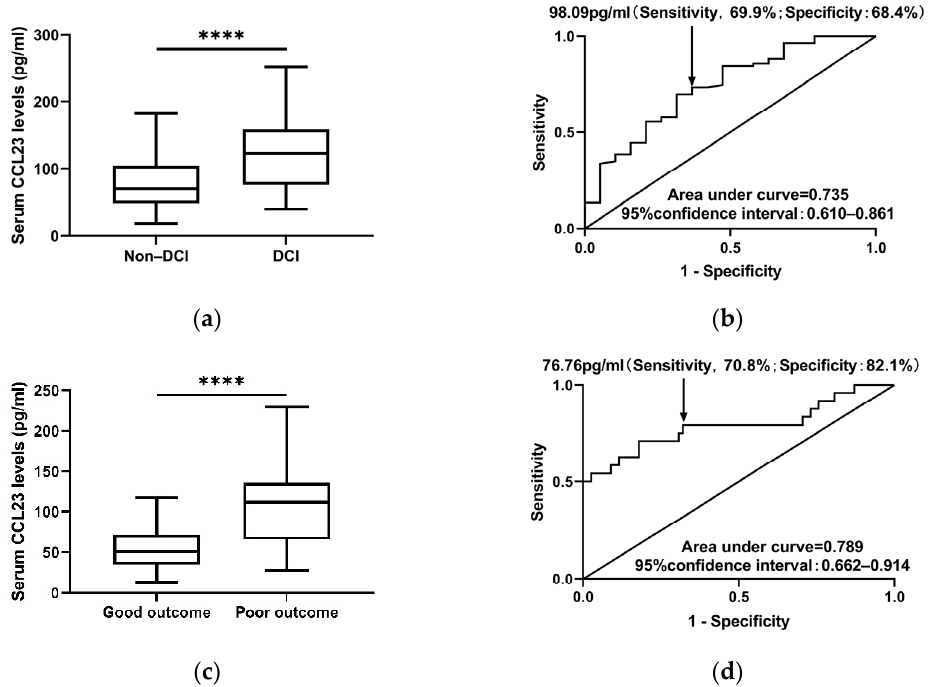
Figure 3. Correlation between serum CCL23 levels with initial clinical severity. ( a ) Scatterplot and regression line show correlation between serum CCL23 levels and Hunt–Hess score at admission. ( b ) Scatterplot and regression line show correlation between serum CCL23 levels and mFisher score at admission. The blue areas represent 95%CI of the regression line; r means Spearmen’s correlation coefficient of two factors.